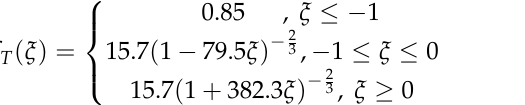
Table 3. Correlation coefficient ( 𝑟 ) and the root mean square error ( RMSE ) between measured and estimated log 10 ( 𝐶 𝑛 2 ) results of different models in four seasons. JF (Winter)